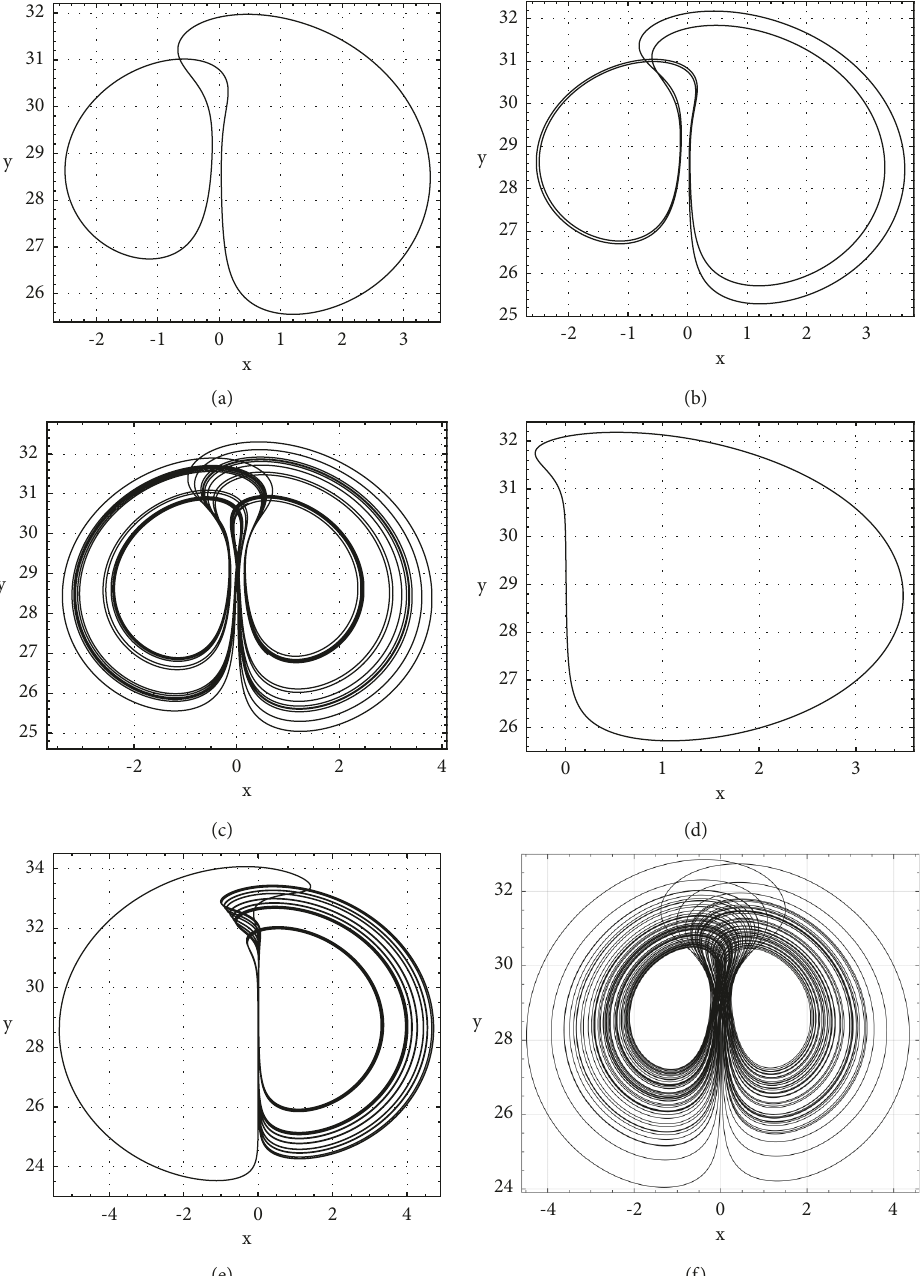
Figure 4: The phase portraits of system (a–c) in planes ( x,y ) for specific value of σ : (a) σ � 1.5, (b) σ � 1.479, (c) σ � 1.32, (d) σ � 3.5, (e) σ � 3.199, and (f) σ � 1.025; the initial conditions are (0.01, 0.01, 20). The system parameters are c � 30; u � 0.009; β � 0.03; v � 0.005; T 3 �